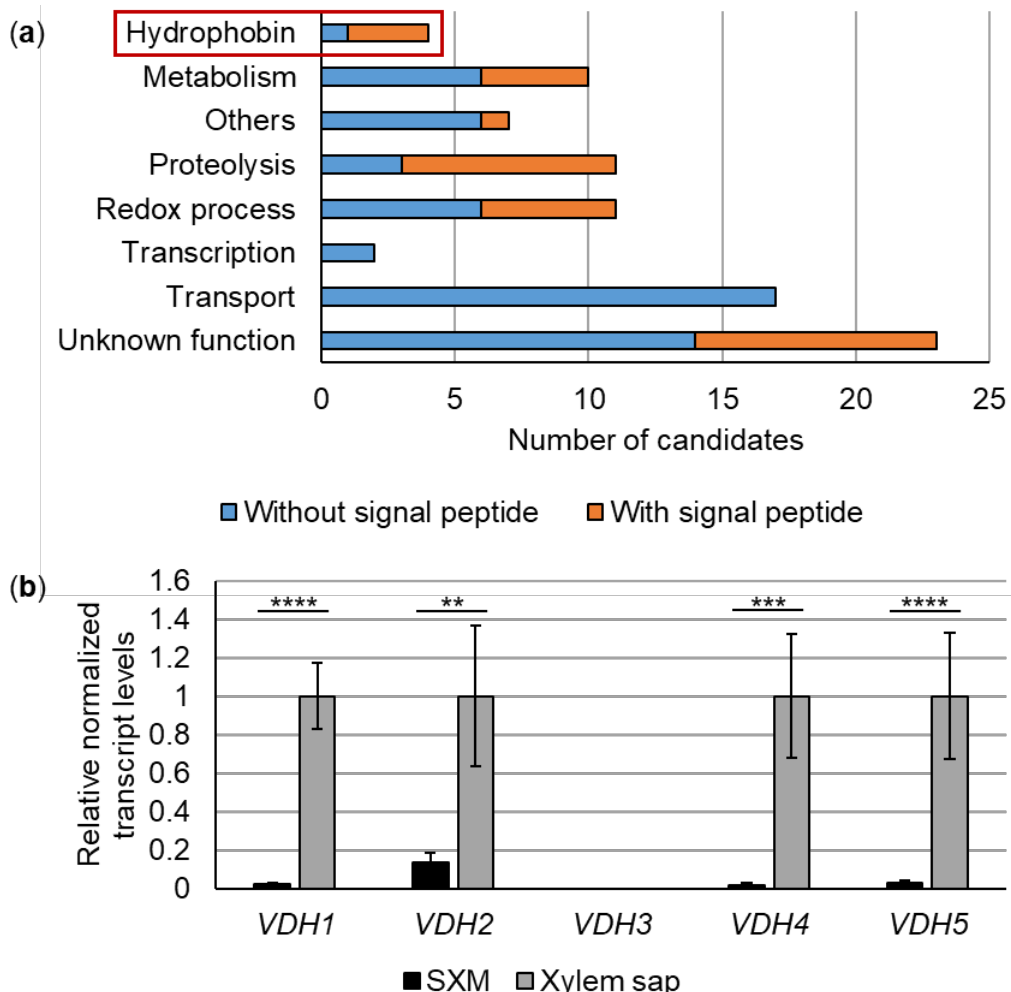
Figure 1. Expression of 85 Verticillium dahliae genes, including four genes encoding hydrophobins, is strongly induced in tomato xylem sap. Wild-type spores of strain JR2 were used to inoculate liquid simulated xylem medium (SXM) and incubated for five days with shaking. Mycelia were then transferred to either extracted tomato xylem sap or SXM and incubated for an additional eight h. ( a ) RNA sequencing was performed on three biological replicates per condition. After applying a log 2 (fold change) cut-off of ≥ 4, transcript levels of 85 genes were significantly higher in cells from extracted tomato xylem sap compared with SXM. InterPro and BLAST were used to assign putative functions based on conserved domains. The products of the differentially expressed genes include hydrophobin proteins (red box), transcription factors, transporters, proteins involved in metabolism, proteolysis and redox processes, and proteins with other or unknown functions. Proteins lacking a signal peptide are shown in blue, whereas proteins containing a predicted signal peptide are shown in orange. Details are provided in Table S2. ( b ) The transcription of hydrophobin-encoding genes was analyzed by reverse transcription-quantitative PCR. Normalization to the transcript levels of the reference genes H2A and EIF2B was performed. Transcript levels for the data from the xylem sap condition were set to one. Mean values from three independent experiments are shown. Significance was calculated using Welch’s t -tests (**, p < 0.01; ***, p < 0.001; ****, p < 0.0001). The transcript levels of VDH1 , VDH2 , VDH4, and VDH5 were significantly higher in the xylem sap versus the SXM condition. The transcript of VDH3 was not amplified in either the SXM or xylem sap conditions. The error bars represent the standard errors of the mean.